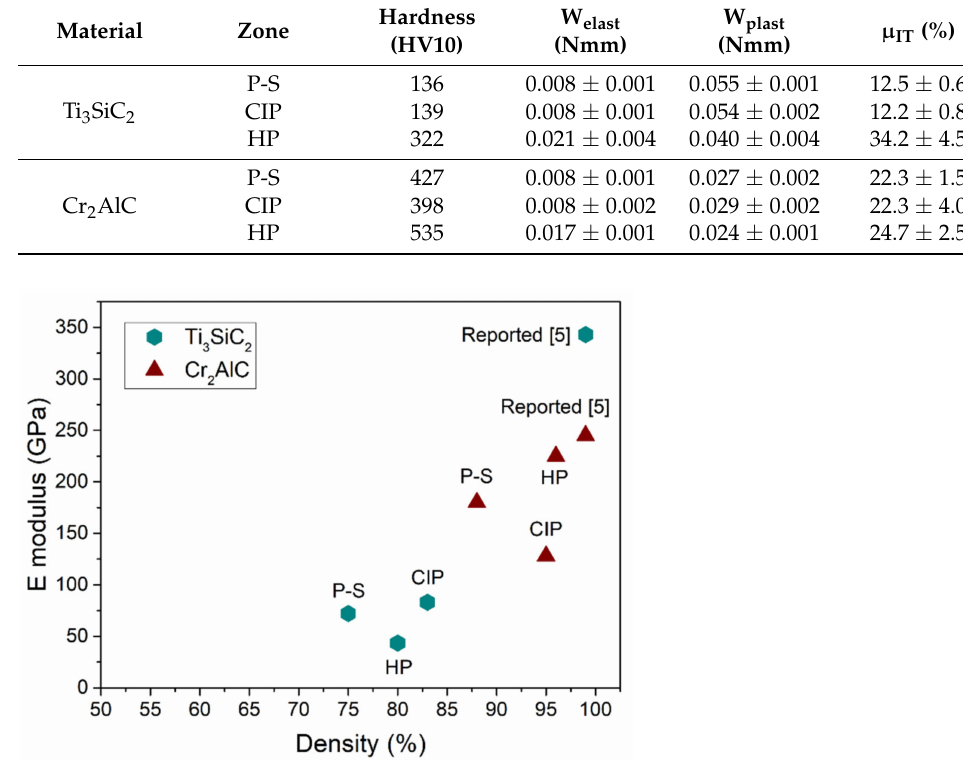
Table 4. A summary of the measured mechanical properties of uniaxially (P-S), cold isostatic pressed and sintering (CIP) and hot-pressed (HP) Ti 3 SiC 2 and Cr 2 AlC MAX phases. W elast and W plast stand for the elastic and plastic work during the indentation and µ IT for the recovery index after releasing the indentation.